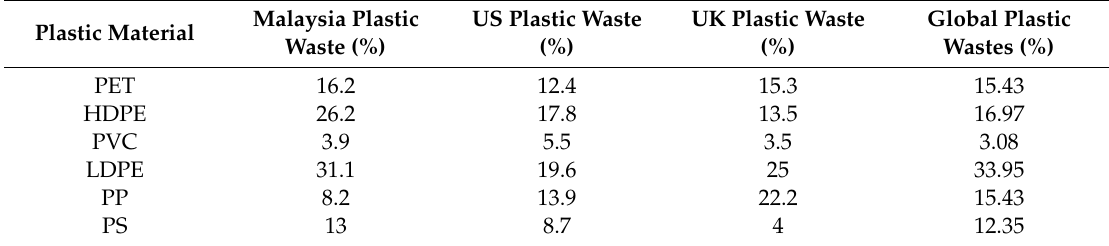
Table 1. Global composition of non-recycled plastics (NRP) waste consisted in municipal solid waste (MSW)